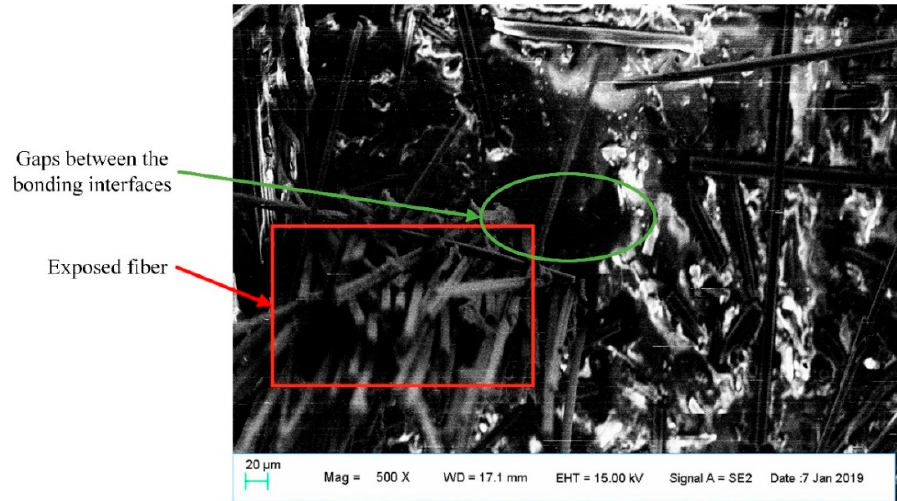
Figure 14. Fiber-matrix bonding interface of continuous carbon fiber-reinforced 3D printing parts.